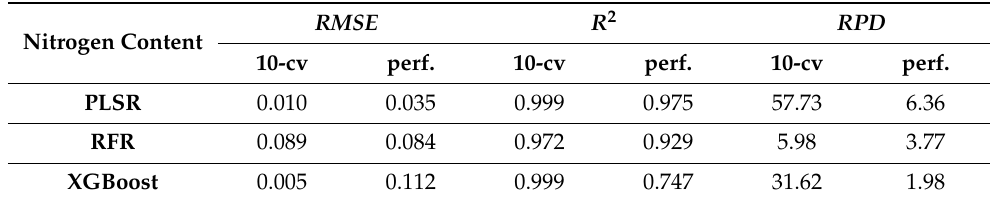
Table 1. Results of the 10-fold cross-validation (10-cv) and results of the performance dataset (perf.) nitrogen content of ML models.